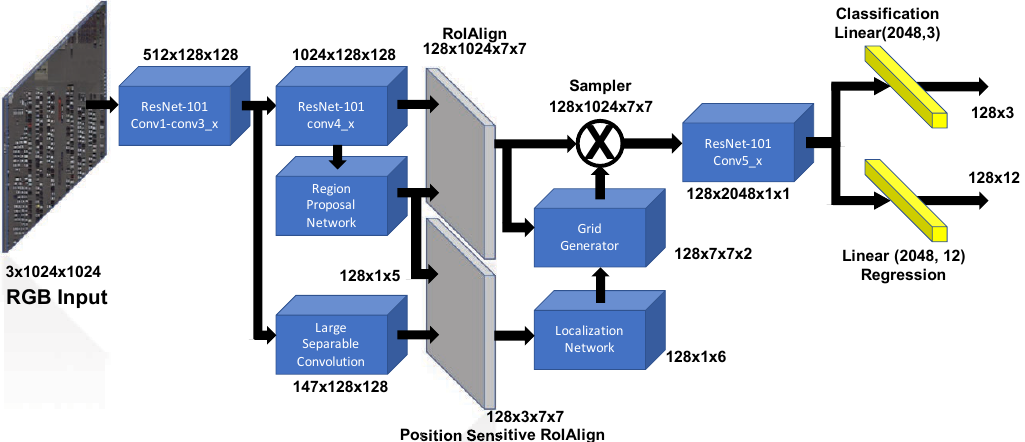
Figure 2. Architecture: The backbone is a ResNet-101. Blue components represent subnetworks, gray color denotes feature maps, and yellow color indicates fully connected layers. The Region Proposal Network (RPN) proposes candidate RoIs, which are then applied to the feature maps from the third and the fourth convolutional blocks, respectively. Afterwards, RoIs from the third convolutional block are fed into the Localization Network to find the transformation parameters of local invariant features, and the Grid Generator matches the correspondence of pixel coordinates between RoIs from the third and the fourth convolutional blocks. Next, the Sampler determines which pixels are sampled. Finally, the regression and classifier output the vehicle detection